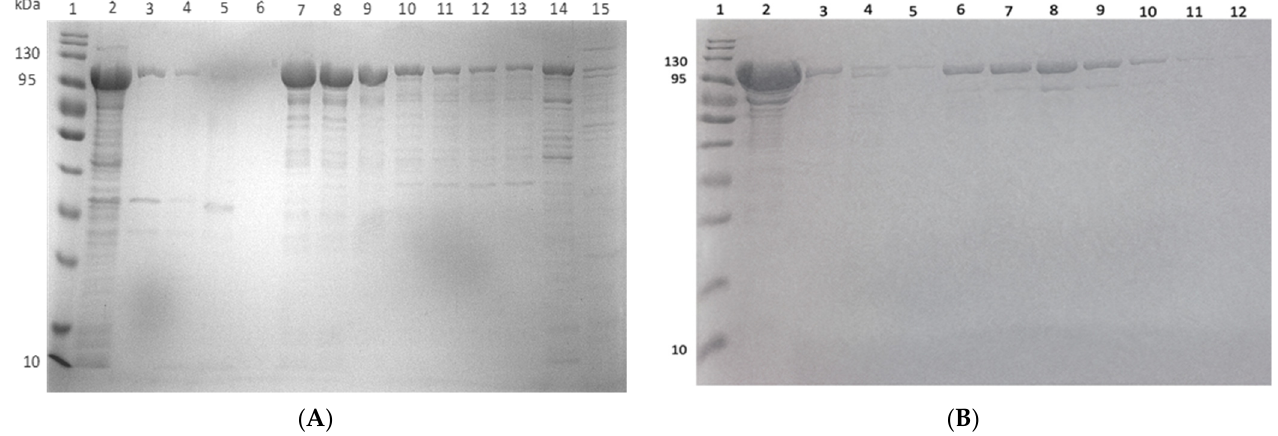
Figure 14. Purification of ClpK using anion exchange and affinity chromatography. ( A ) Anion ex-